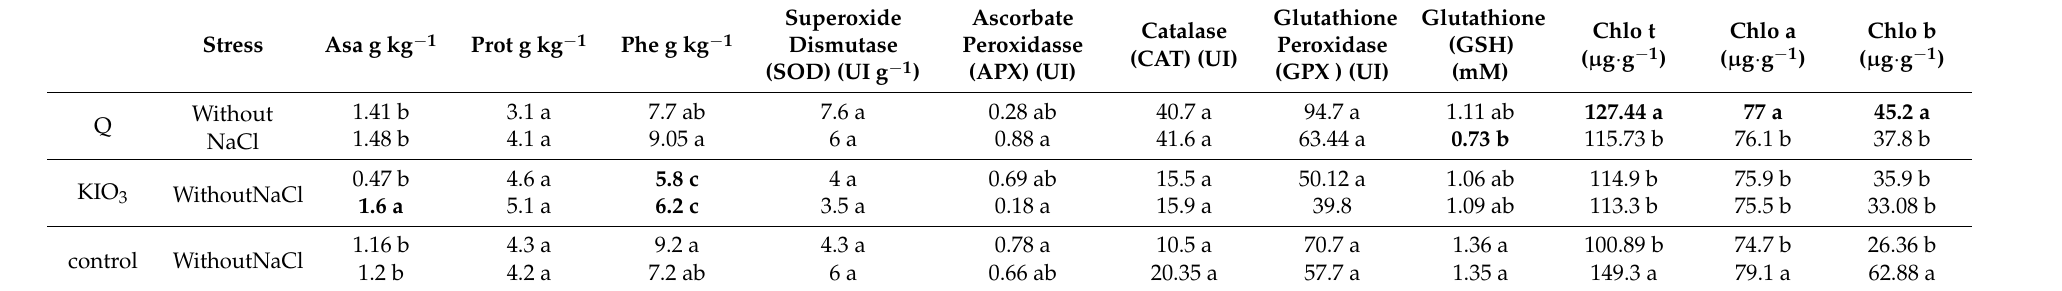
Table 5. Effect of iodine- based products on antioxidants content in leaves, with and without salt stress.